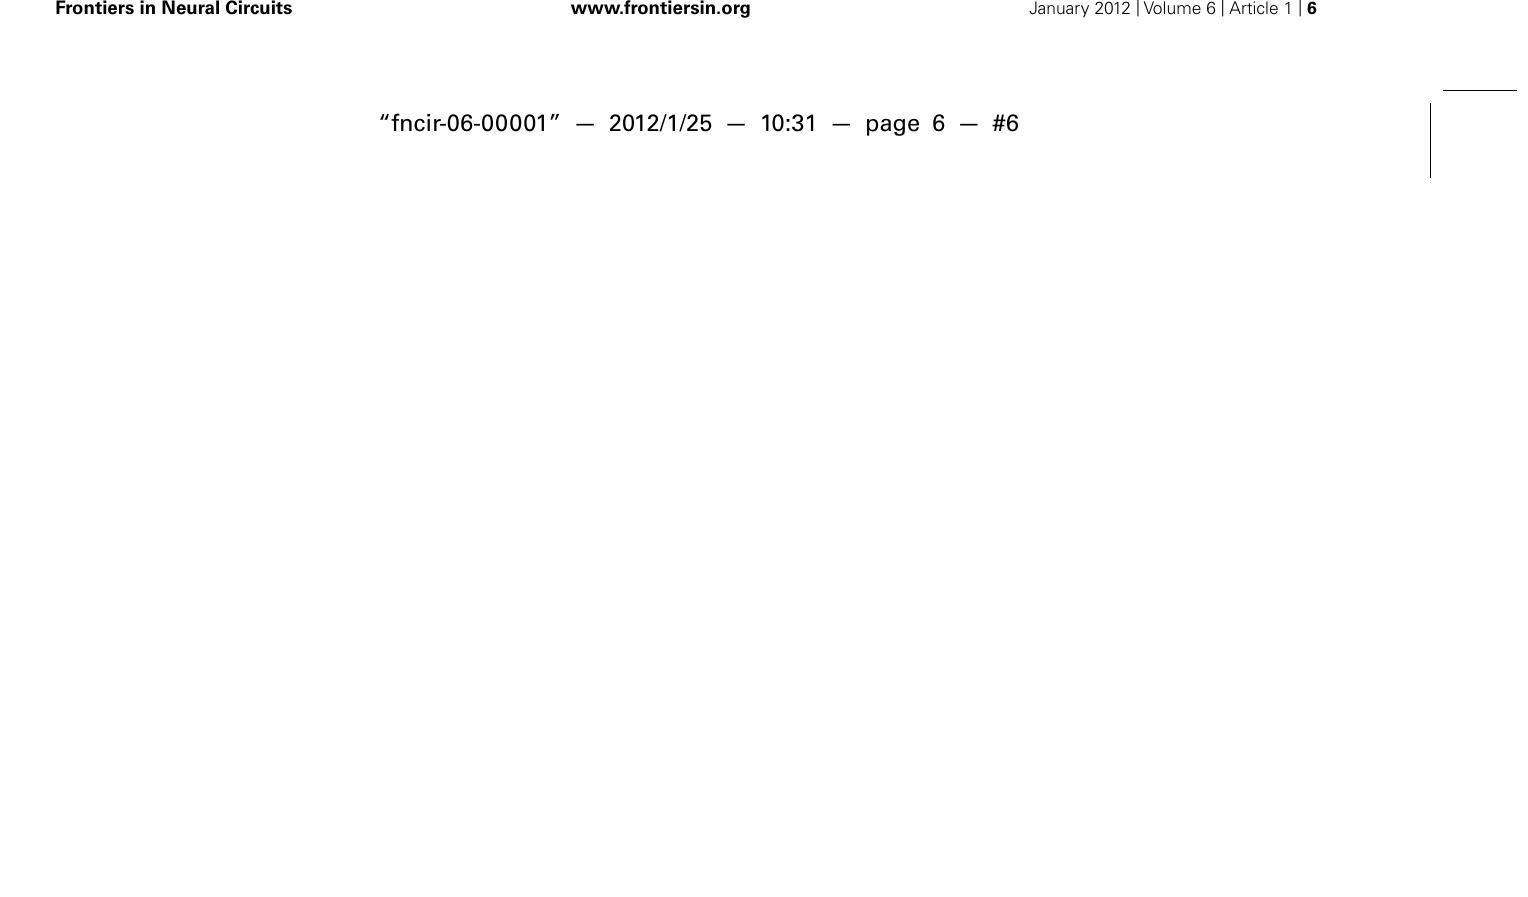
between 10 and 160 Hz.The color scale represents signal power ( μ V 2 ) . (C) . Normalized average power spectra (60–160 Hz) during spontaneous activity in GLAST + / + ( n = 6) and GLAST − / − ( n = 6) mice. Frequency and power of gamma oscillations are significantly reduced in GLAST − / − compared to controls. (D) Peaks values averaged for the population [GLAST + / + ( n = 6); GLAST − / − ( n = 6)] confirm the frequency shift and power decrease in GLAST − / − animals. ** p <